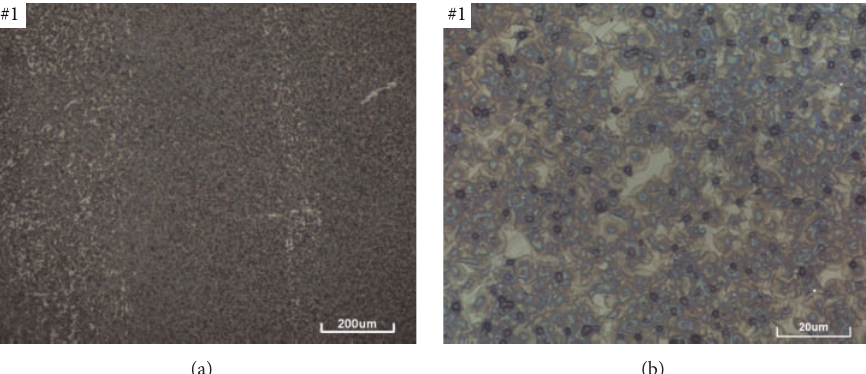
Figure 3: Optical image of platelets on surface of untreated polymer PET (#1) coated with heparin after incubation with fresh blood at two different magnifications ((a) and (b)).